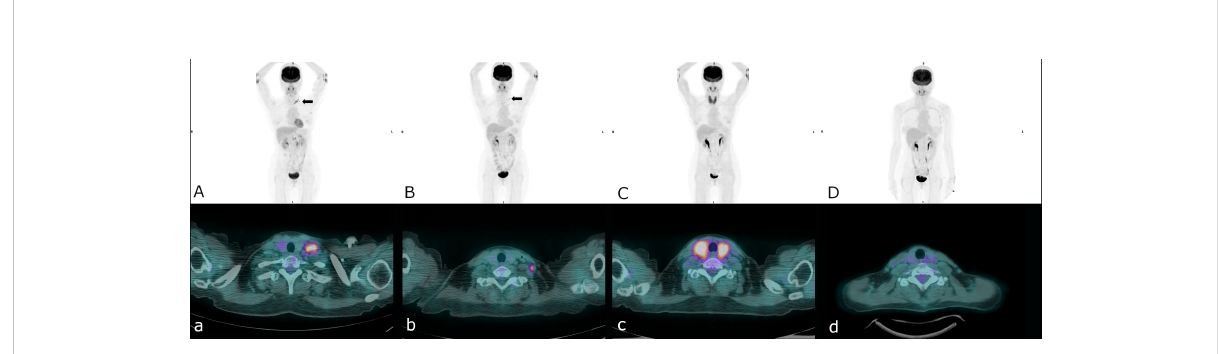
FIGURE 1 A serial pelvic MRI: T2-weighted sagittal and DWI-axial views and PET/CT images during treatment and follow-up (A) First recurrence at left supraclavicular lymph nodes (arrow), (B) Second recurrence at left lower neck lymph nodes (arrow), (C) Complete remission of second recurrence, thyroiditis was also noted, (D) Sustained free of disease since stopping